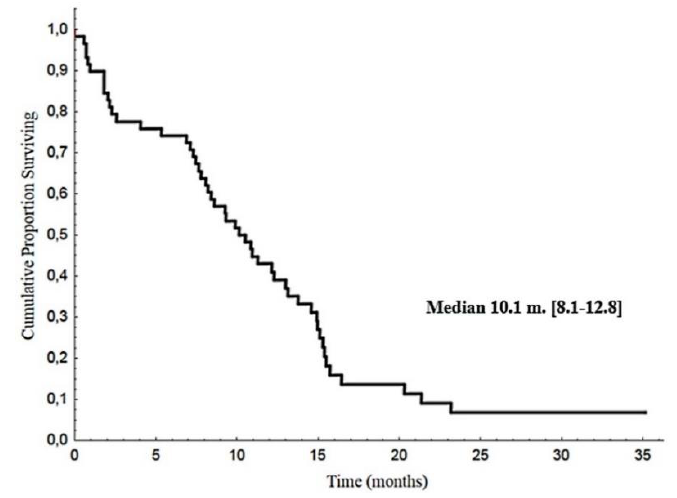
Figure 1. Progression-free survival.